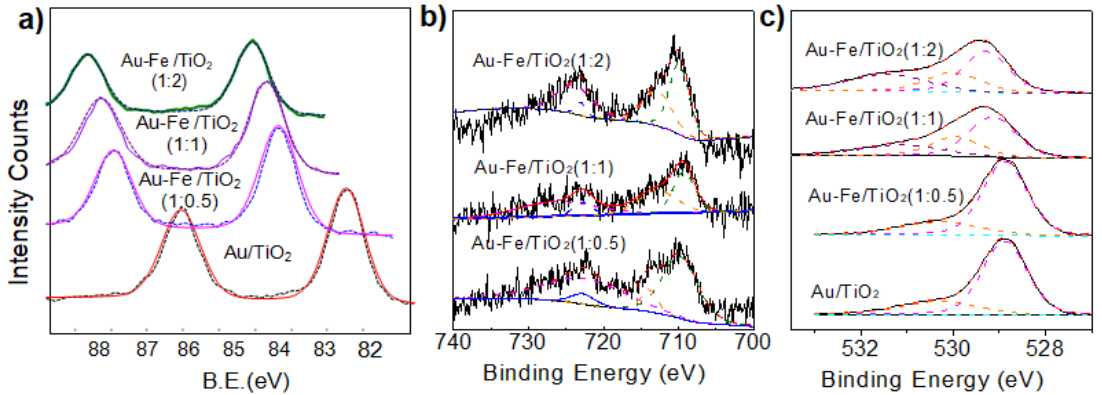
Figure 5. XPS spectra of ( a ) Au4f, ( b ) Fe2p, ( c ) O1s of Au / TiO 2 and Au-FeO x / TiO 2 photocatalysts. The BE peaks at ~709.8 eV (Fe2p 3/2 ) and 722.7 eV (Fe2p 1/2 ) are characteristic of Fe 2+ species in the